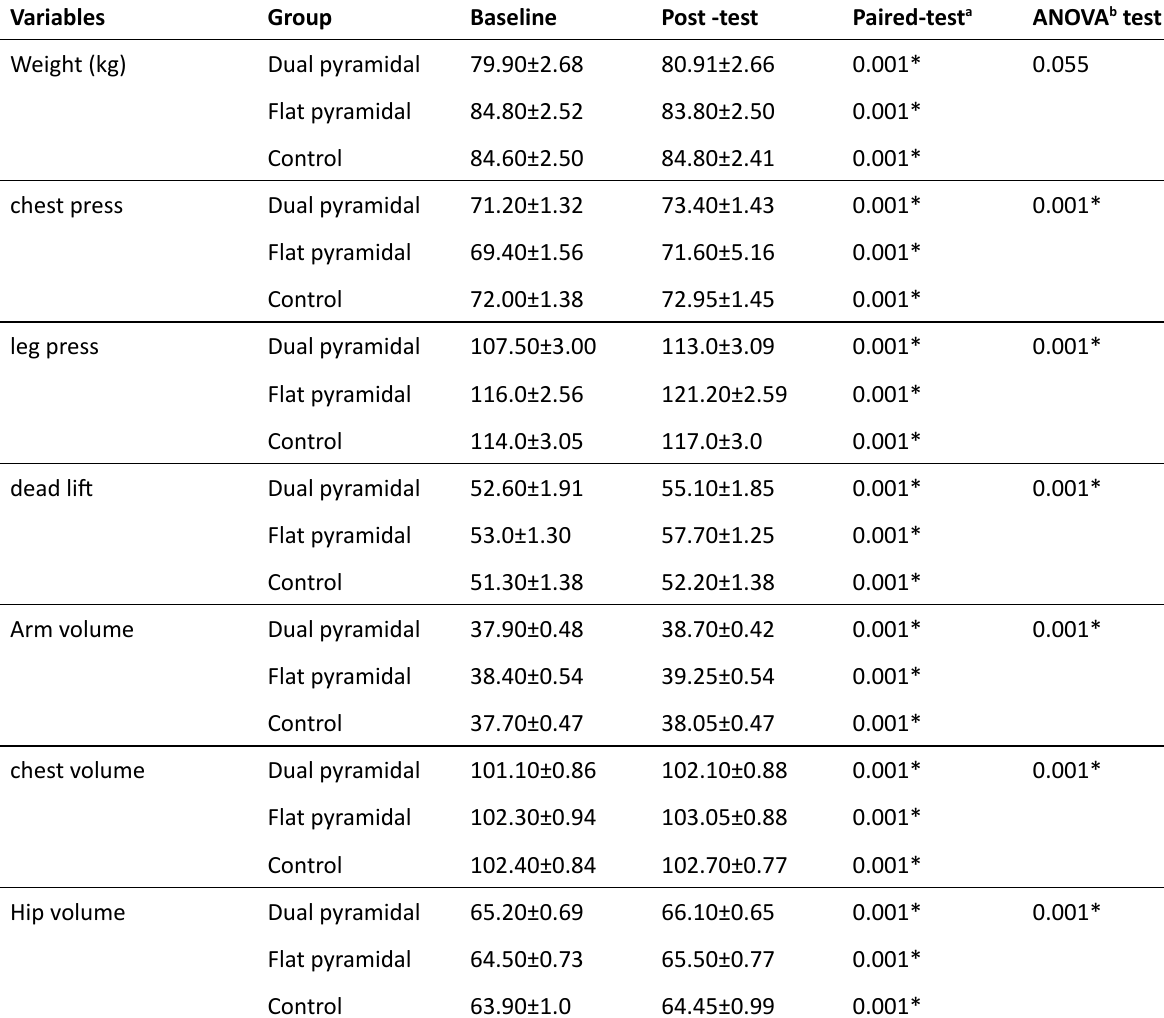
Table 3. Changes of Research Variables Groups Before and After 8 Weeks of Resistance Training